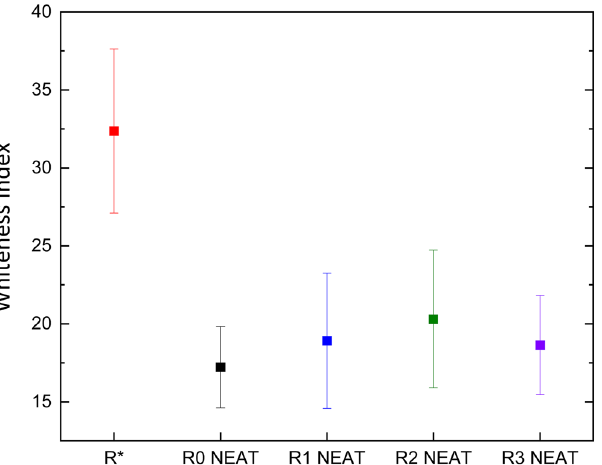
Figure 2. Whiteness Index values for the original pellet (R*), matrices obtained through IM process (R0) and further reprocessing (R1–R3).